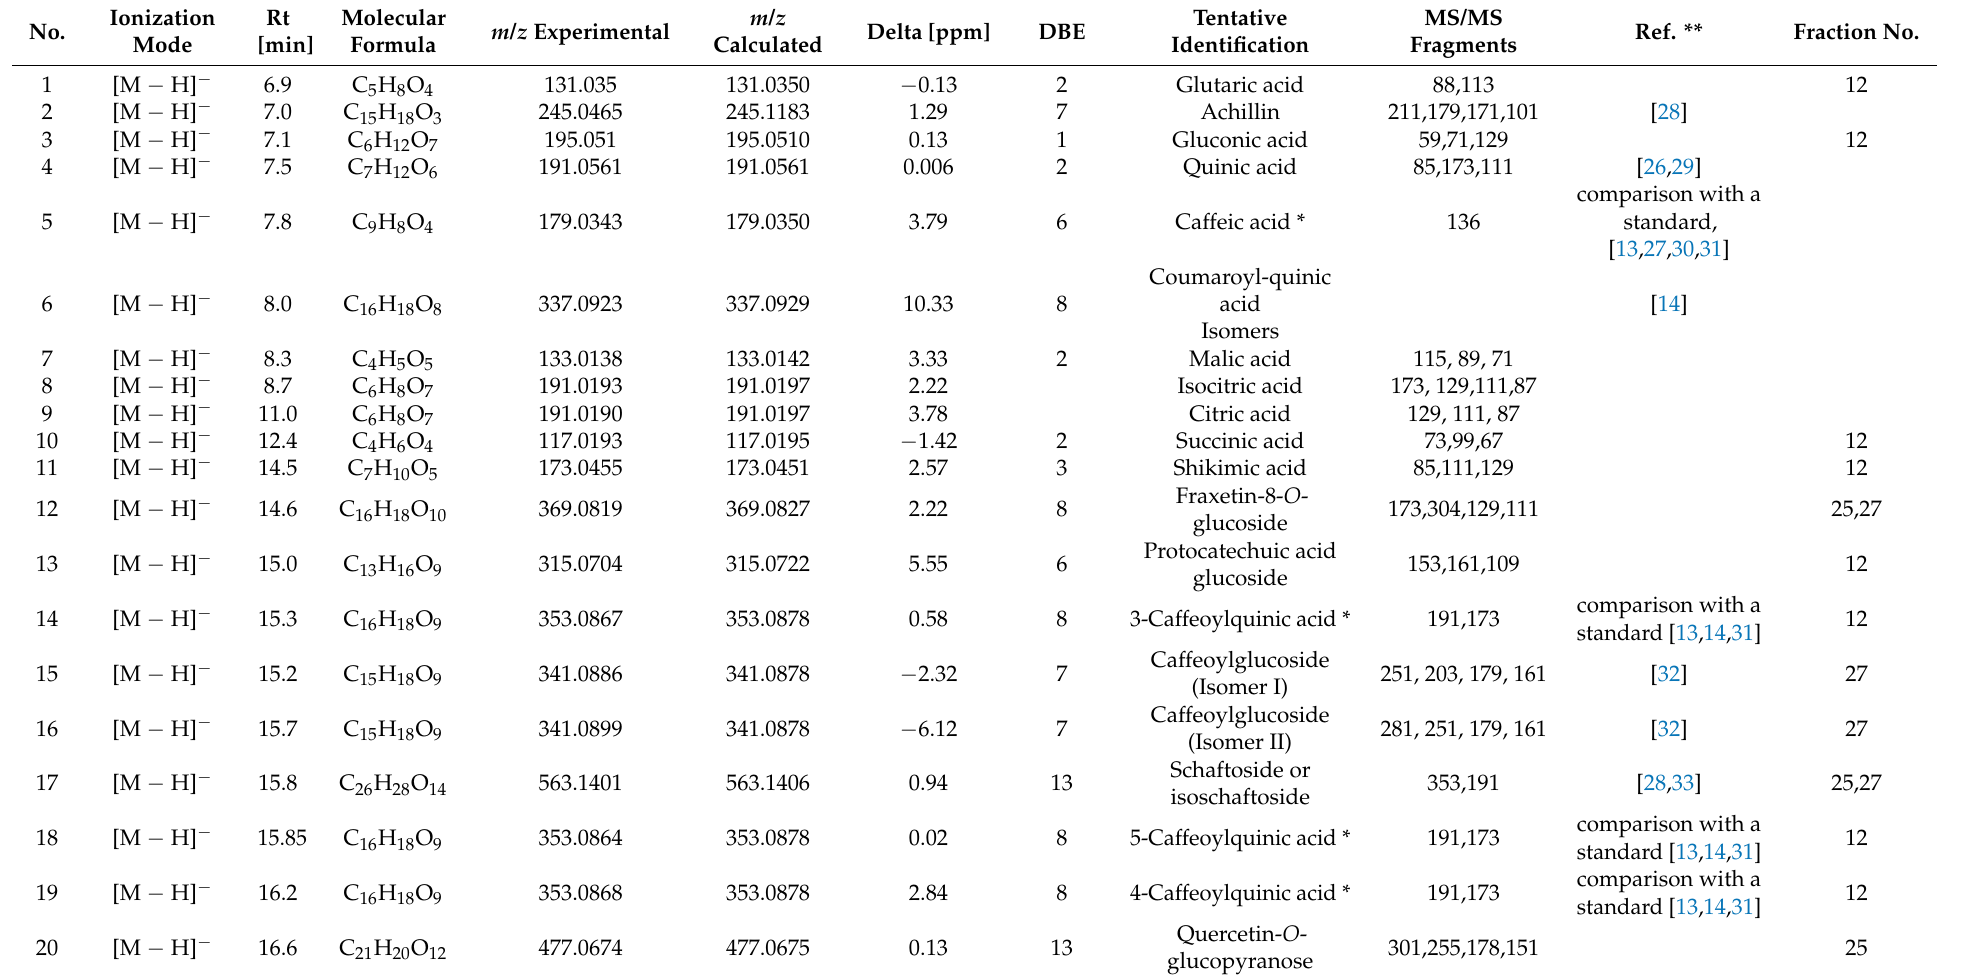
Table 1. The identified compounds in E6 extract from Achillea biebersteinii using an HPLC-ESI-Q-TOF-MS/MS (Rt = retention time, Delta = difference between experimental and calculated mass (mmu), DBE = double bond